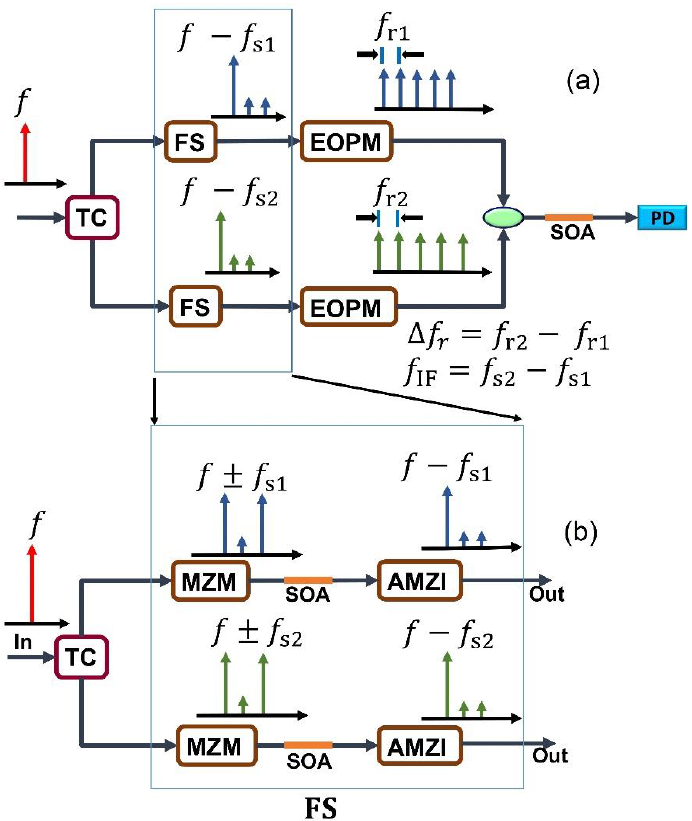
Figure 2. ( a ) System architecture, including the comb generator stage using two phase modulators. ( b ) Zoom into Frequency shifter stage. The spectral behavior is described stage by stage. Both MZMs (Mach-Zehnder Modulators) are operated with RF driving frequencies equal to f s 1 and f s 2 . The difference between these frequencies will be the IF frequency f IF , where the shrunken comb will be centered. These frequencies should be high enough to ease the filtering with the FSR (Free Spectral Range) of the AMZI (Asymmetric Mach-Zehnder Interferometer). The AMZIs are tuned with a DC voltage until it filters one of the sidebands that both MZMs deliver. The EOPMs (Electro-Optic Phase Modulator) on the comb generation stage are driven with RF voltages equal to f r 1 and f r 2 . The difference between these two repetition frequencies will be the repetition of the shrunken comb equal to ∆ f r . Since we need to generate a dual comb, the phase modulators for comb generation should be just after the frequency shifter stage. If a simple electro-optic frequency shifter or an electro-optic modulator for telecommunications is required, we can disable one branch by tuning the TC (Tunable Coupler) to direct the beam through one of the optical paths and leave the EOPM free, with no modulation applied. SOAs (Semiconductor Optical Amplifiers) are utilized to compensate for losses and to absorb the power remaining of the disabled